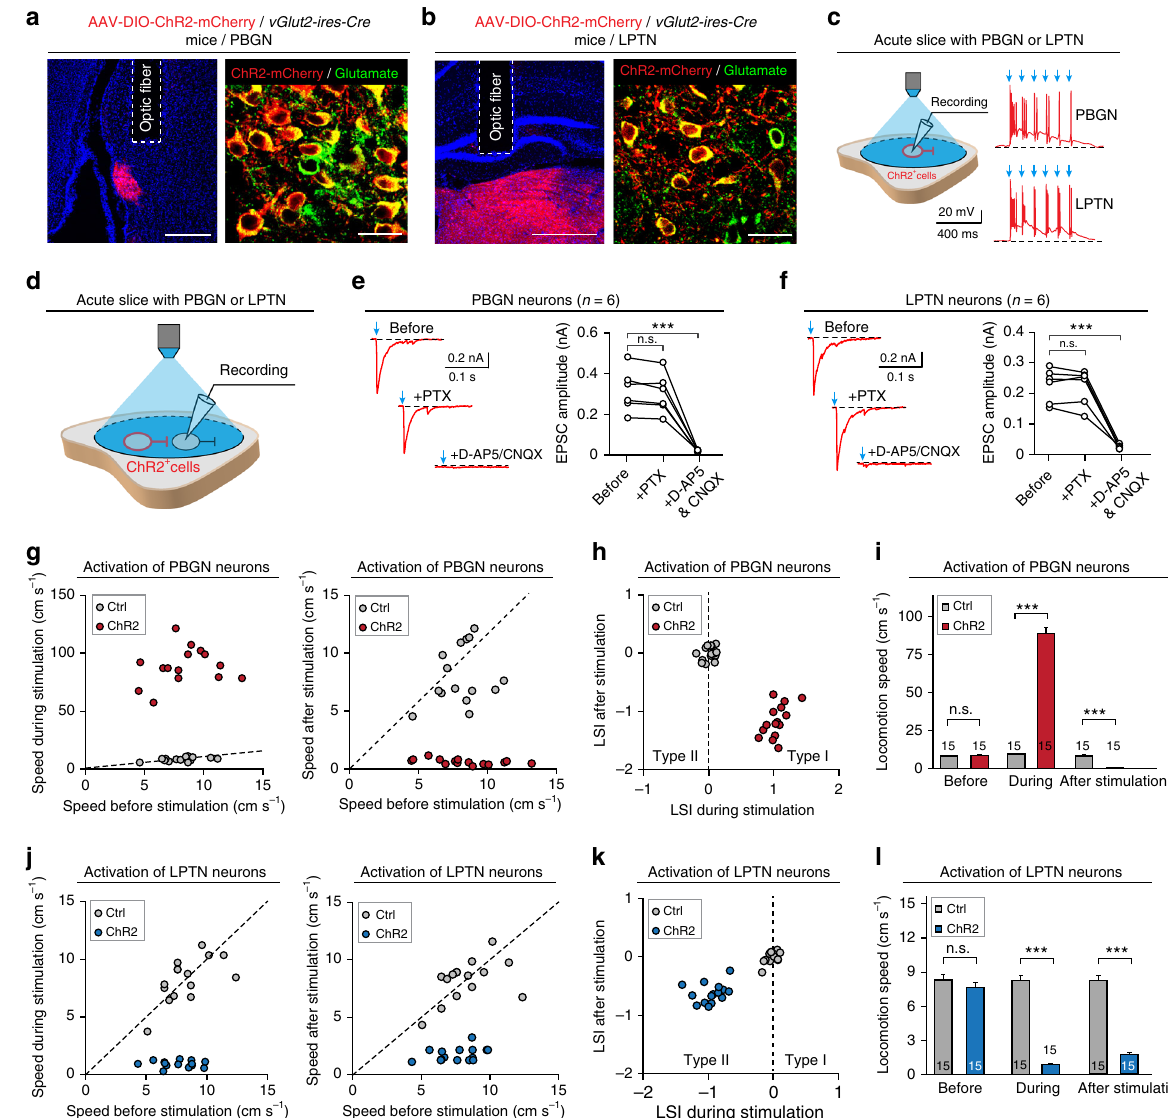
Fig. 7 Selective activation of glutamatergic neurons in the PBGN and LPTN triggers dimorphic defensive response patterns. a , b AAV-DIO-ChR2-mCherry was locally injected into the PBGN ( a , left) and LPTN ( b , left) of vGlut2-ires-Cre mice, resulting in the speci fi c expression of ChR2-mCherry in glutamate + neurons in the PBGN ( a , right) and LPTN ( b , right). Scale bars, 0.4 mm (left) and 30 μ m (right) for ( a ) and ( b ). For single-channel micrographs and quantitative analyses, see Supplementary Fig. 7g and h. c In acute slice with the PBGN or LPTN, light-pulse trains (473 nm, 1 ms, 10 Hz, 6 pulses, 20 mW) reliably evoked APs from ChR2-mCherry + neurons in the PBGN and LPTN. d Schematic diagram showing recording of light-evoked PSCs from ChR2- mCherry-negative neurons in acute slice with PBGN or LPTN. e , f Effects of PTX and D-AP5/CNQX on light-evoked PSCs recorded from ChR2-mCherry- negative neurons in the PBGN ( e ) and LPTN ( f ). g , j Distributions of locomotion speed of mice during vs. before (left) and after vs. before (right) optogenetic activation of PBGN ( g ) and LPTN neurons ( j ). h , k Distribution of LSI during stimulation and LSI after stimulation of mice with (ChR2) or without (Ctrl) optogenetic activation of PBGN ( h ) and LPTN neurons ( k ). i , l Quantitative analyses of speed before, during, and after optogenetic activation of PBGN ( i ) and LPTN neurons ( l ). Data in ( i , l ) are means ± SEM (error bars). Numbers of mice are indicated in the bars. Statistical analysis ( e , f , i , l ) was Student ’ s t test (*** P < 0.001; n.s. P > 0.1) and LPTN neurons (Fig. 9a, b). The ef fi ciency of AAV-DIO- Interestingly, selective increase of excitability of PBGN neurons EGFP-2A-NaChBac to increase neuronal excitability was exam- by NaChBac expression increased the proportion of mice with ined by whole-cell recording from the EGFP + PBGN or LPTN Type I behavioral pattern (From 66.7 to 100%; Fig. 9h − j). neurons in acute slices, with AAV-DIO-EGFP as a control (Fig. NaChBac expression in bilateral LPTN increased the proportion 9c). The EGFP + neurons in both PBGN and LPTN slices infected of mice with Type II behavioral pattern (From 26.7 to 60%; Fig. by AAV-DIO-EGFP-2A-NaChBac (NaChBac) fi red more action 9k − m). These data indicated that increased excitability of PBGN potentials in response to depolarizing currents than the control or LPTN neurons can shift the behavioral outcome to the pattern neurons (Ctrl) (one-way ANOVA, PBGN: P < 0.001, LPTN: dominated by PBGN or LPTN, respectively. Together, the data of P < 0.001; Fig. 9d – g). synaptic inactivation (Fig. 8) and of increased excitability (Fig. 9) suggested that the SC-PBGN and SC-LPTN pathways form two | DOI: 10.1038/s41467-018-03580-7 |